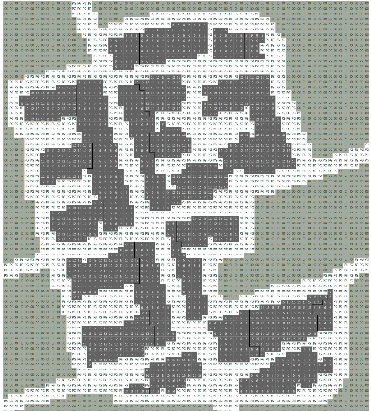
Figure 2. Layout of Yuhou Street.